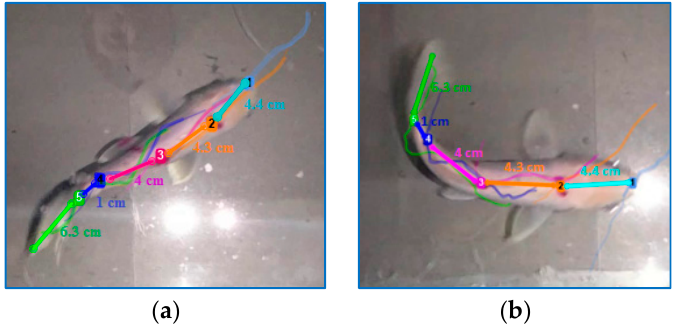
Figure 2. Trajectory study of two swimming patterns of carp. The fish is simplified as a 5-joint linkage represented by different colors. The light color curves indicate a trajectory of the corresponding joint within a period of swimming pattern: ( a ) Forward swimming pattern, period 350 ms; ( b ) Turning swimming pattern, period 550 ms.